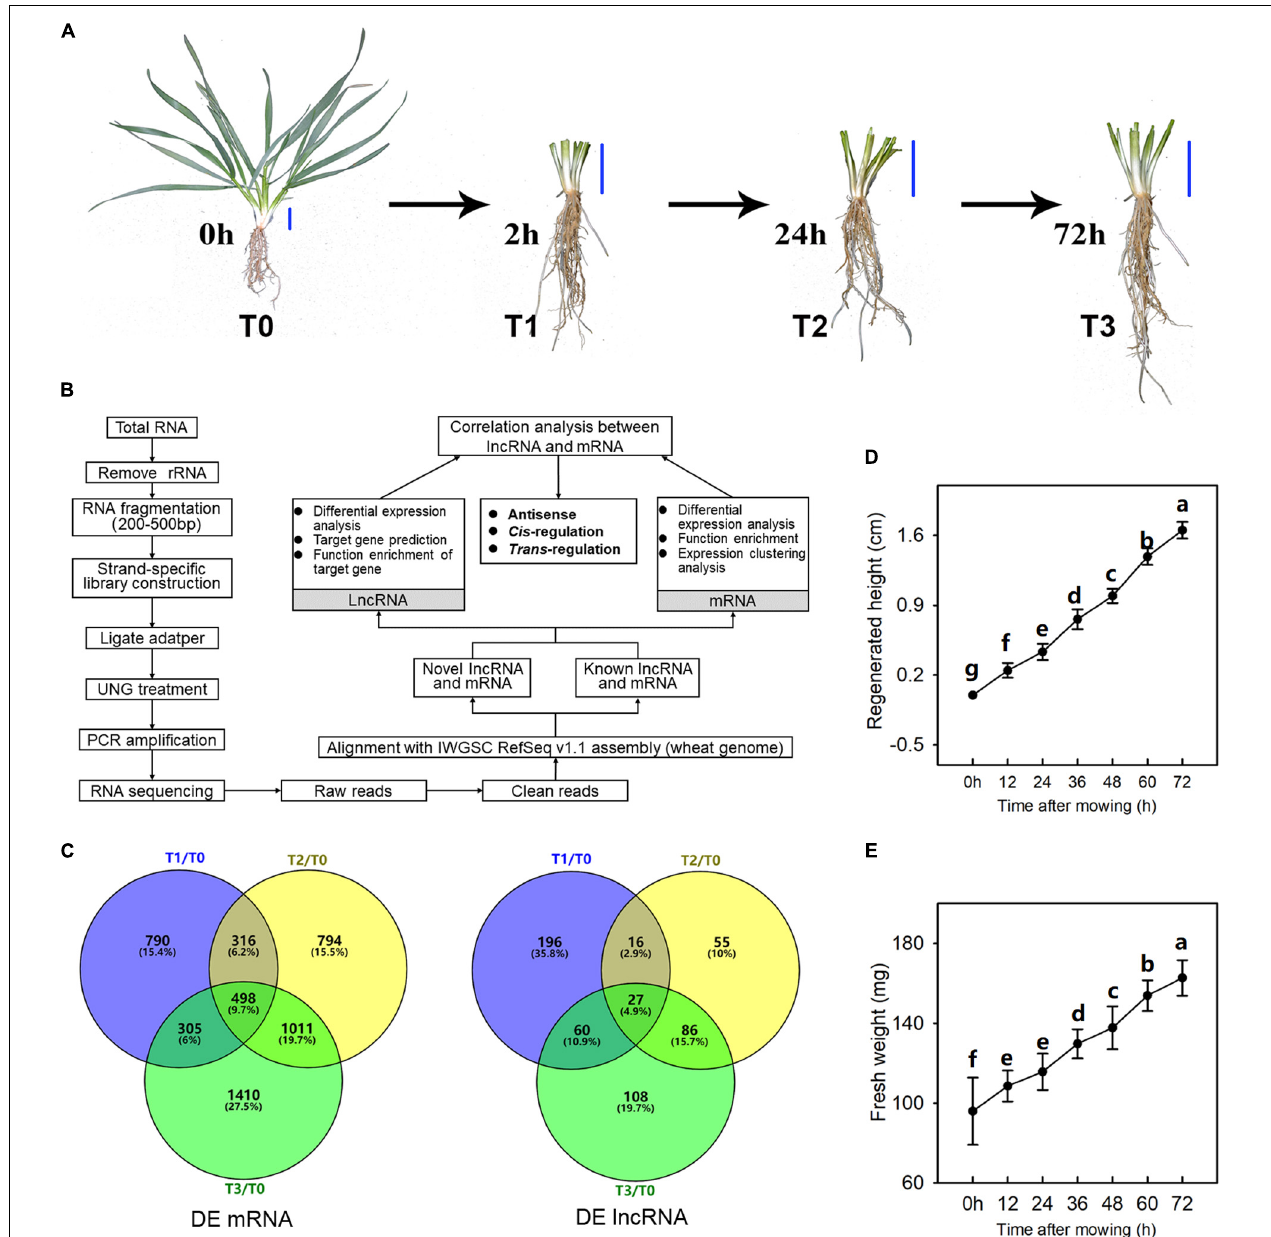
FIGURE 1 | Regeneration process of wheat seedlings following mowing. (A) Regeneration process of wheat seedlings and sampling time (T0, T1, T2, and T3 means the sample was harvested at 0, 2, 24, and 72 h after mowing, respectively.). The blue bar represents a three-centimeter reference growth scale. (B) RNA isolation and bioinformatic analysis. Three biological replicates were used for this analysis. (C) Venn diagram of differentially expressed mRNAs (DE mRNA) and lncRNAs (DE lncRNA). (D,E) The wheat seedlings were harvested every 12 h within 72 h after mowing. The height of regenerated young leaves was measured, and the fresh weight of the aboveground parts of the main tiller of wheat seedlings was determined. Data are the mean values of 15 independent replicates ( n = 15), and error bars show the standard error. Duncan’s multiple-comparison test was used for ANOVA, and different lowercase letters indicate a significant difference at the level of P <